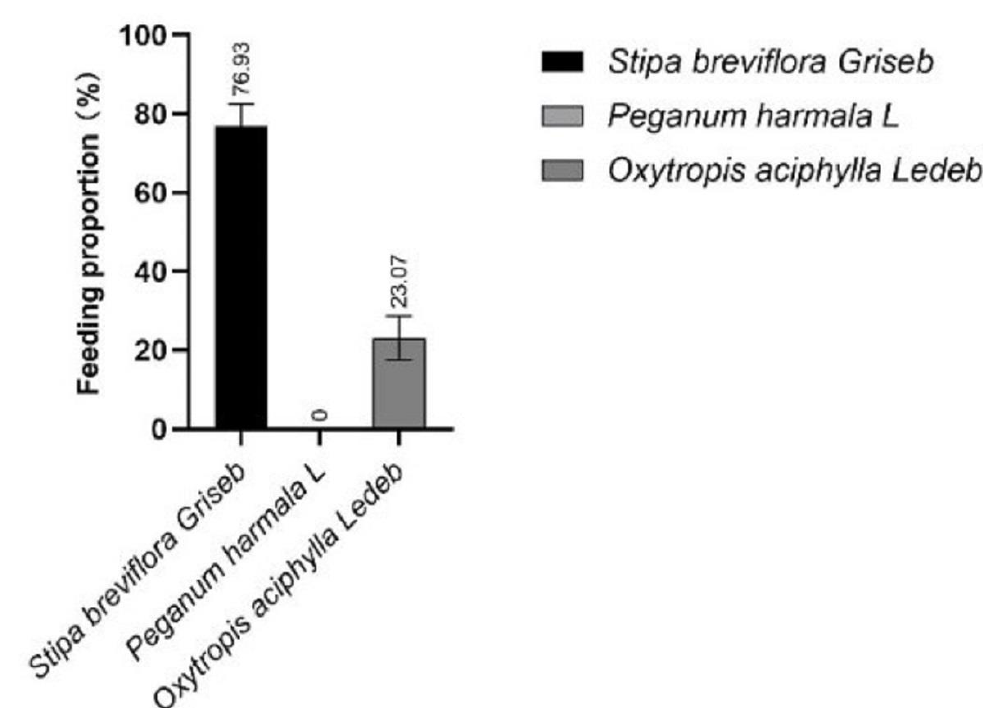
Figure 1. Forage intake proportion of cashmere goats in early gestation (%).